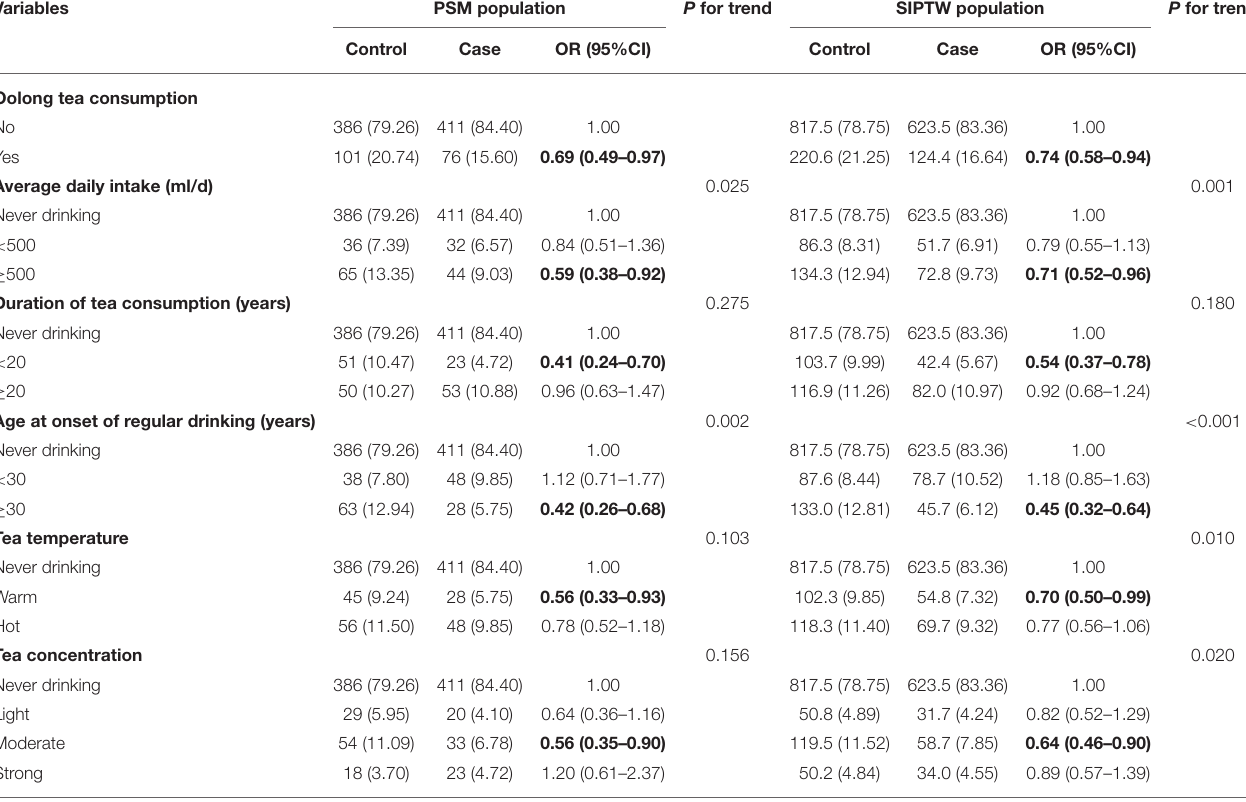
TABLE 2 | The relationship between oolong tea-drinking habits and OSCC risk after propensity score analyses. Variables PSM population P for trend